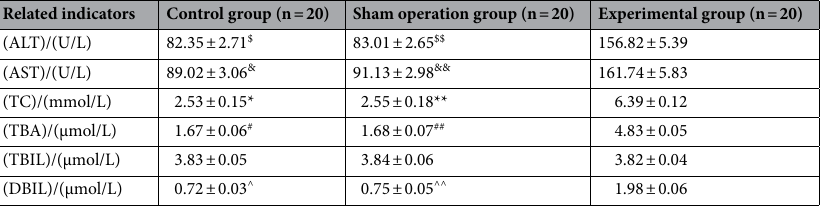
Table 3. Changes of liver function. $ P < 0.05 compared with the experimental group, & P < 0.05 compared with the experimental group, * P < 0.05 compared with the experimental group, # P < 0.05 compared with the experimental group, ^ P < 0.05 compared with the experimental group. $$ P < 0.05 compared with the experimental group, && P < 0.05 compared with the experimental group, ** P < 0.05 compared with the experimental group, ## P < 0.05 compared with the experimental group, ^^ P < 0.05 compared with the experimental group. The levels of alanine aminotransfease, aspartate transaminase, total cholesterol, total bilirubin, and direct bilirubin in control group and sham operation group were lower compared with those in the experimental group. ALT: alanine aminotransfease, AST: aspartate transaminase, TC: total cholesterol, TBA: total bile acids, TBIL: Total bilirubin, DBIL: direct bilirubin. (SPSS22.0 http://www.downx ia.com/downi nfo/16552 3.html).